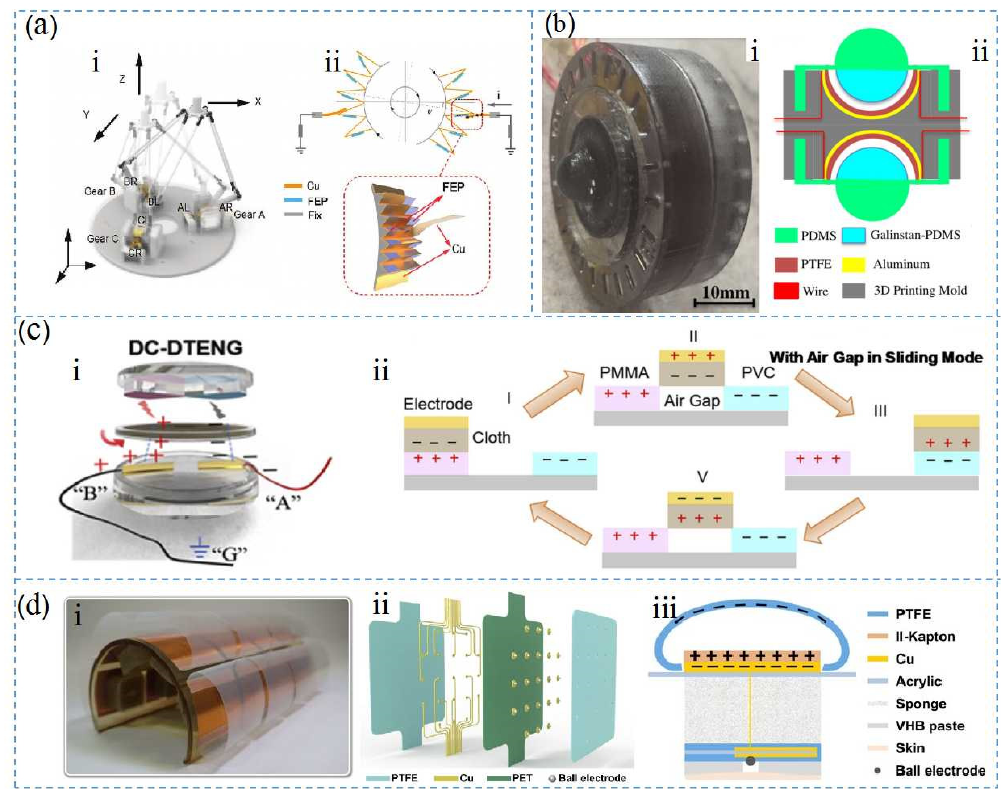
Figure 6. Structure of the VR products: ( a ) TENG fabricated from the FEP film used for mobile platform control, Reprinted with permission from ref. [34]. Copyright 2021 Advanced Materials Technologies; ( b ) material structures and physical photos of a self-powered sensor made with PDMS and PTFE, Reprinted with permission from ref. [41]. Copyright 2018 Nano Energy; ( c ) internal structure diagram and material hierarchy diagram of DC-DTENG, Reprinted with permission from ref. [43]. Copyright 2020 Nano Energy ; ( d ) material structure of an electro-tactile system based on TENG and spherical electrode array formation, Reprinted with permission from ref. [39]. Copyright 2021 Science Advances. 5. Applications of TENG in AR and VR Qiongfeng et al. proposed a TENG based on two configurations to realize more HMI functions and make signal processing easier. Each sensor consisted of a PEDOT:PSS- coated textile tape and the gloves were coated with a layer of silicone film (Figure 7a) [113]. This type of HMI was used for unmanned driving technology, and the operation technology was simple and intuitive, as the four sensors were represented by different finger movements. Figure 7b shows the real-time outputs of the sensors when the fingers were bent downward at different angles at the same speed [114]. This HMI could control the car, drive it in different directions, and the running state of the car could be changed according to the finger bending angle and strength of the operator. (Figure 7c,d). To address the issue of human sweat on glove performance, a simple CNT and TPE coating method was proposed by Qiongfeng et al., which is shown in Figure 7e, to achieve superhydrophobic triboelectric textiles with improved performance [115,116]. The super- hydrophobic fabric recovered quickly from high humidity conditions seven times faster than the original fabric, and the triboelectric properties were three times better. Superhydrophobic triboelectric textiles collected biomechanical energy from human activities at four times the power density of the original textiles[117]. In a high humidity environment, superhydrophobic textiles with anti-perspiration properties can monitor human movements without obvious output voltage deterioration. Figure 7g, h shows the applications of superhydrophobic triboelectric gloves in an AR space. Figure 7g shows the control of firearms in a 3D shooting game, where each sensor on the glove was connected